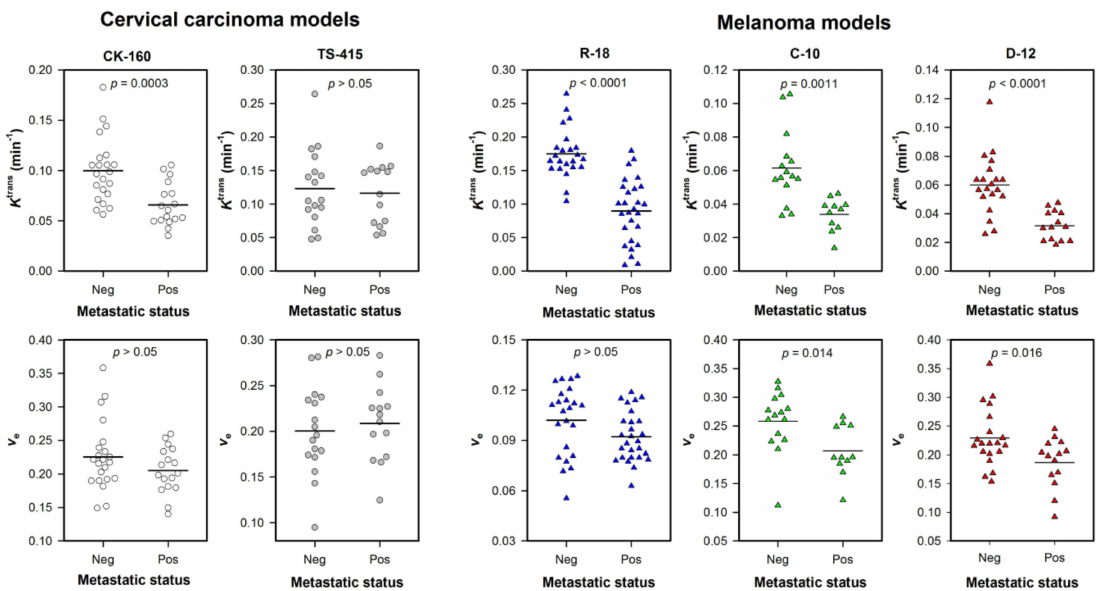
Figure 7. Tumors were subjected to DCE-MRI before the tumor-bearing mice were euthanized and examined for lymph node and pulmonary metastasis. The figure shows median K trans and median v e in metastasis-negative and metastasis-positive CK-160 and TS-415 cervical carcinoma xenografts, and R-18, C-10, and D-12 melanoma xenografts. Mice with CK-160, TS-415, and R-18 tumors showed lymph node metastasis, and C-10 and D-12 tumors developed spontaneous pulmonary metastasis. Points represent individual tumors and lines represent mean values. p -values were obtained by Student’s t -test. Modified from Ellingsen et al. [26], Øvrebø et al. [36], and Øvrebø et al.